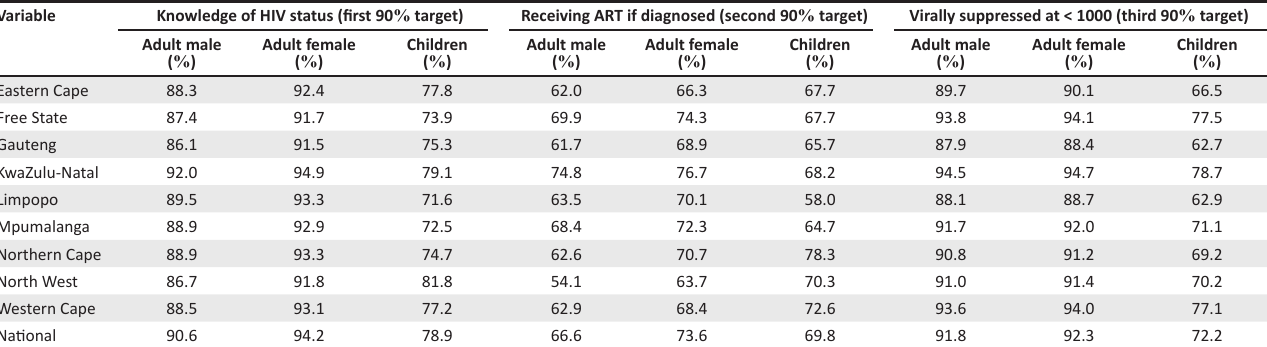
TABLE 1: Progress towards the 90-90-90 targets in 2019. Variable Knowledge of HIV status (first 90 %